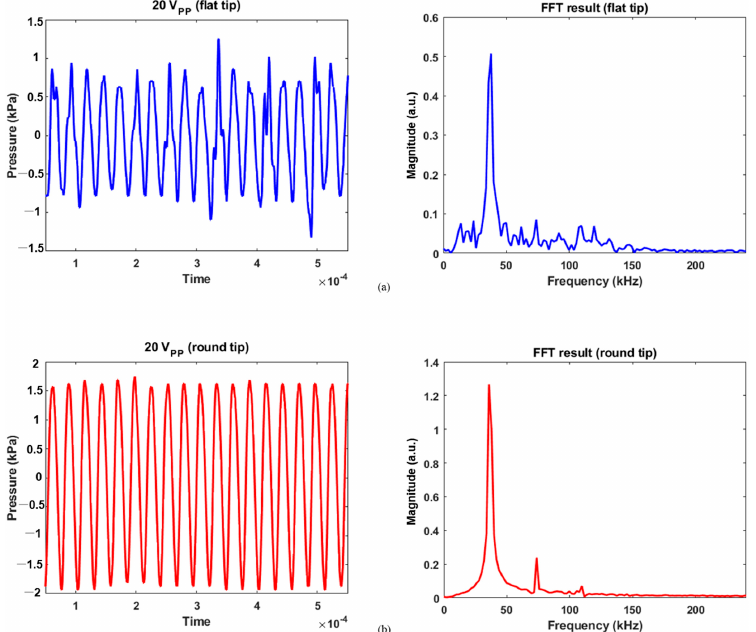
Figure 6. Calibration data for 20 V pp and its FFT results: ( a ) flat tip, ( b ) round tip. For 20 V pp excitation, the flat tip generated 1.25 and − 1.33 kPa as maximum positive and negative pressures in Figure 6a, respectively. As reduced electrical energy was input, the recorded pressure contained a lower level of noise over the same frequency range. The magnitude was 0.51 for the fundamental frequency and 0.09 for the second harmonic. Similarly, the pressure was measured between 1.75 and − 1.94 kPa for round tip. As com- pared with Figure 5b, Figure 6b showed that noise components were more suppressed; their FFT results were 1.27, 0.24, and 0.07 at the fundamental, second, and third harmonic frequencies. This implies that as the area of round tip was greater than that of flat radiator, the bubble collapse was less significant. A previous study also confirmed this fact: when a tip has smaller active area for acoustic emission, the bubble oscillation becomes more violent than that of a round tip [14]. When a spherical tip generates radial wave propaga- tion, it induces a unique phase of acoustic streaming not seen for the flat tip, resulting in a large cavitation gas volume. In contrast, a rectangular tip causes a different fluid flow distribution, which produces bubble collapse activity at the tip’s surface. Furthermore, the cavitation phenomenon’s shielding effect renders acoustic waves to lose energy while penetrating the cavitation zone. It causes pressure plots to fluctuate, as seen in the flat-tip results [15,16]. The resultant values were determined by averaging the measured acoustic power from five separate trials, as summarized in Table 1.